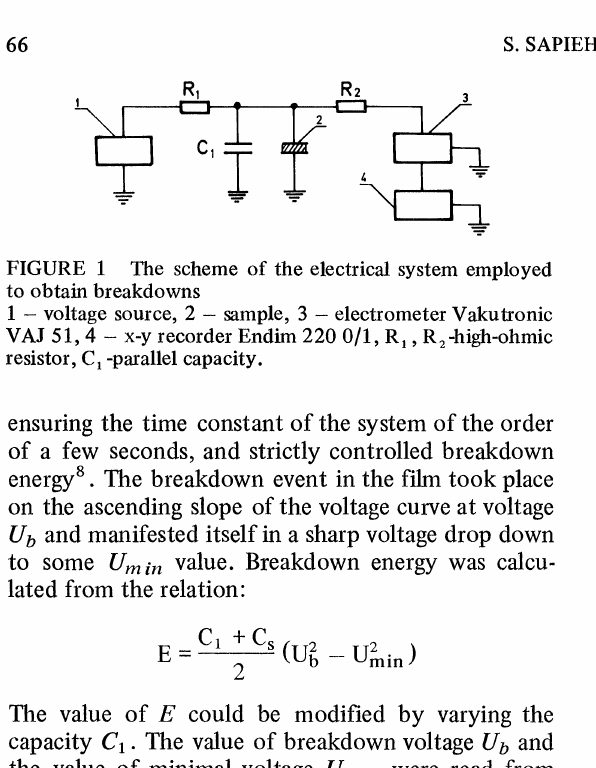
The scheme of the electrical system employed to obtain breakdowns voltage source, 2 sample, 3 -electrometer Vakutronic VAJ 51, 4